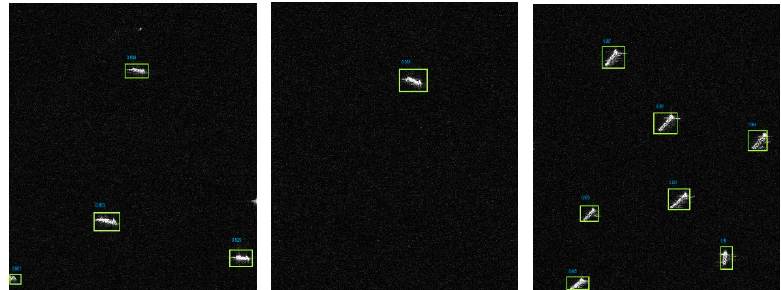
Figure 6. Ship detection result using our approach, YOLOv7+GNN . Figure 7. Ship detection result using our approach, YOLOv7 +